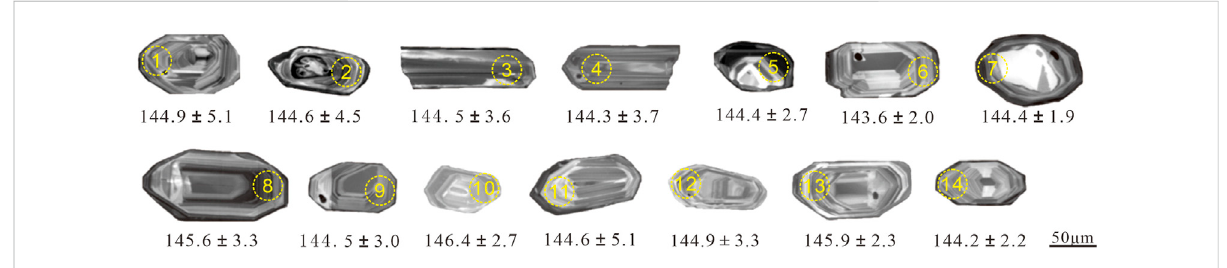
FIGURE 4 CL images of selected zircons from t alkali-feldspar granite samples in the Erguna Block. Yellow circles are the locations of U – Pb